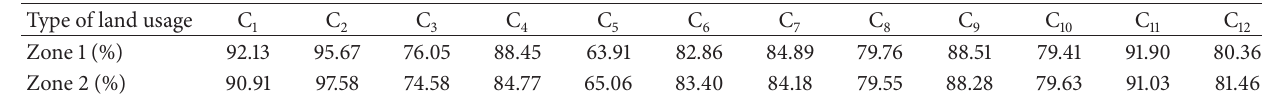
Table 8: Land usage classification accuracy (zone 1).